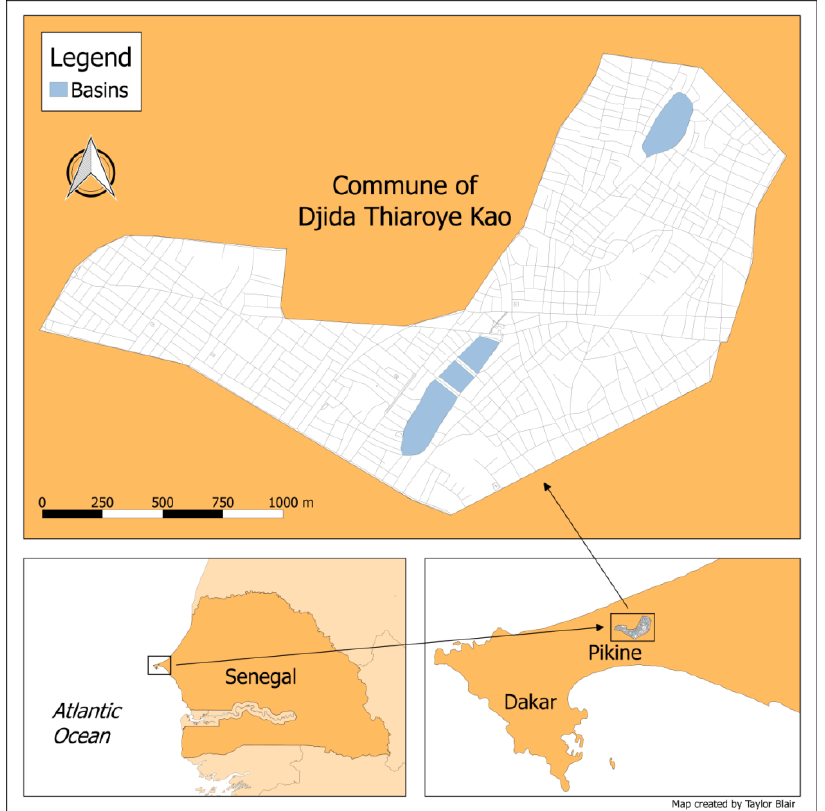
Figure 1. Location of the Djida Thiaroye Kao Commune and its flood catchment basins.